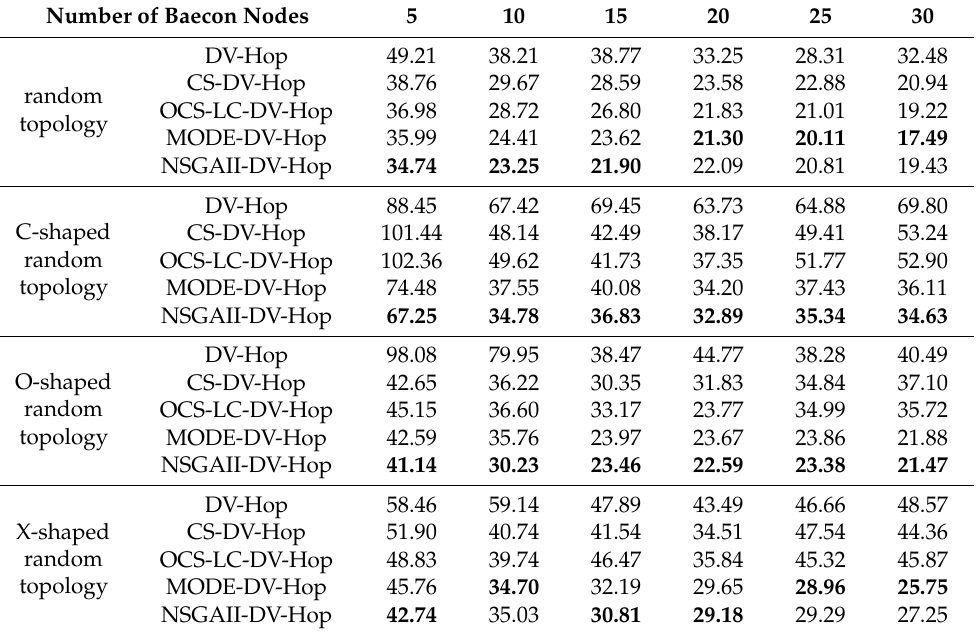
Table 4. ALE of different algorithms in different network topologies and number of beacon nodes. Number of Baecon Nodes